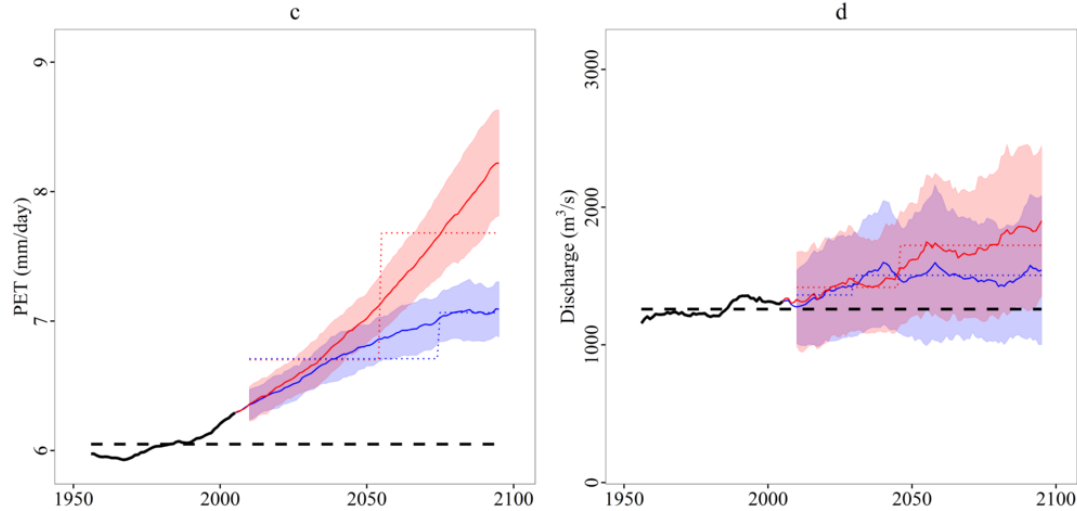
Figure 4. Projected annual climate and discharge trends from eight GCMs in the Niger Basin. ( a ) Rainfall; ( b ) temperature; ( c ) PET; ( d ) discharge: thick black line represents ensemble mean historical trend (1961–2005), red lines represent ensemble mean RCP8.5, blue lines represent ensemble mean RCP4.5; standard deviations across the GCMs are shown in surrounding bounds. Dotted lines show significant ( p < 0.01) regime shifts and dashed black lines is the historical mean.